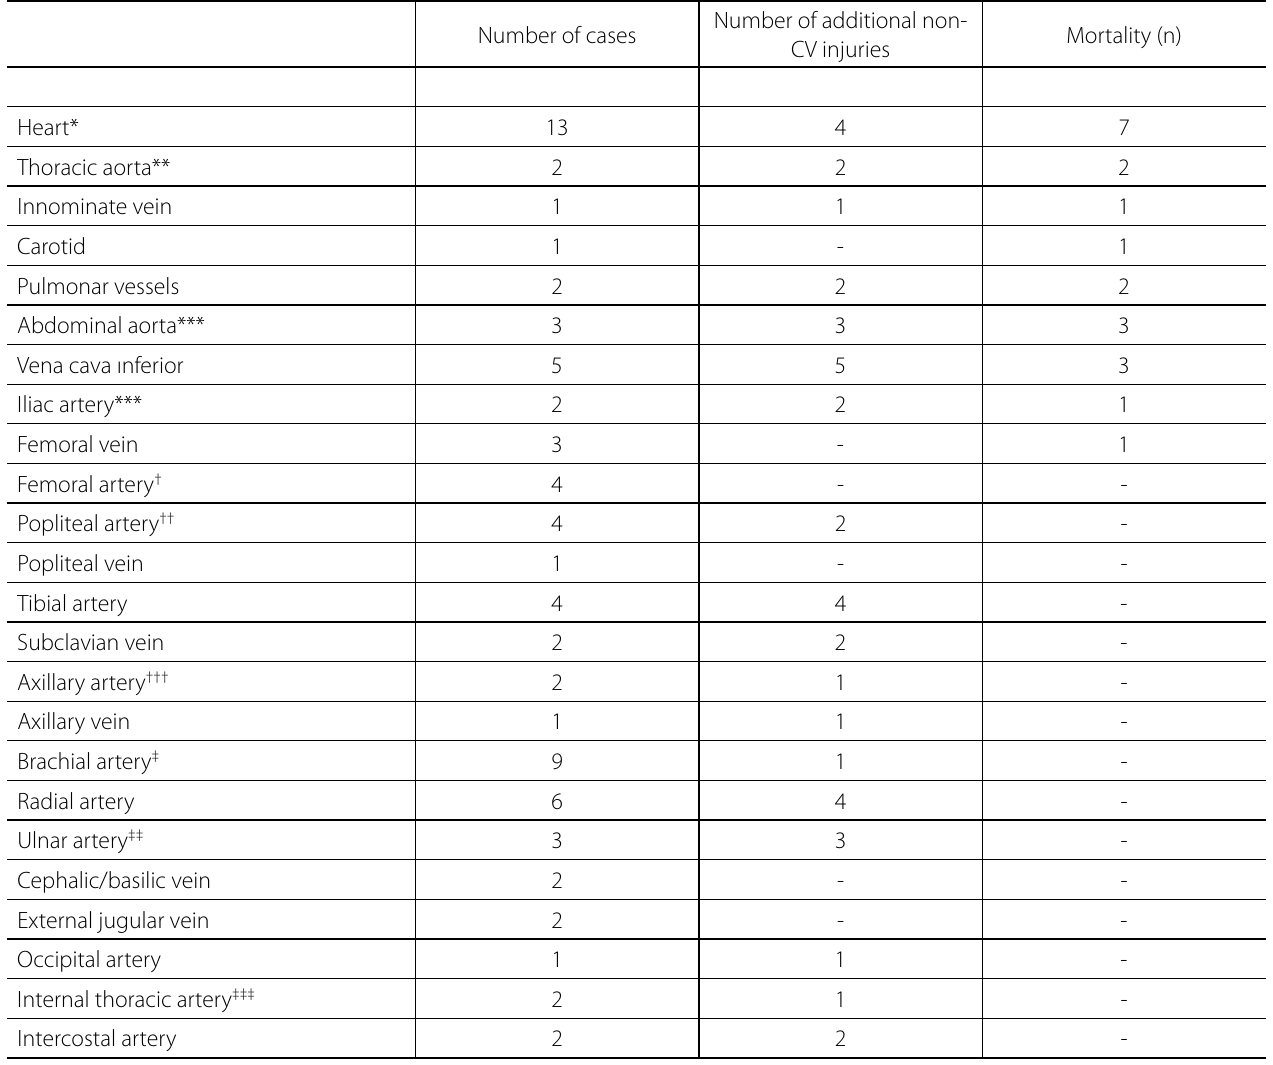
Table 2 . Patients’ injured structures and related